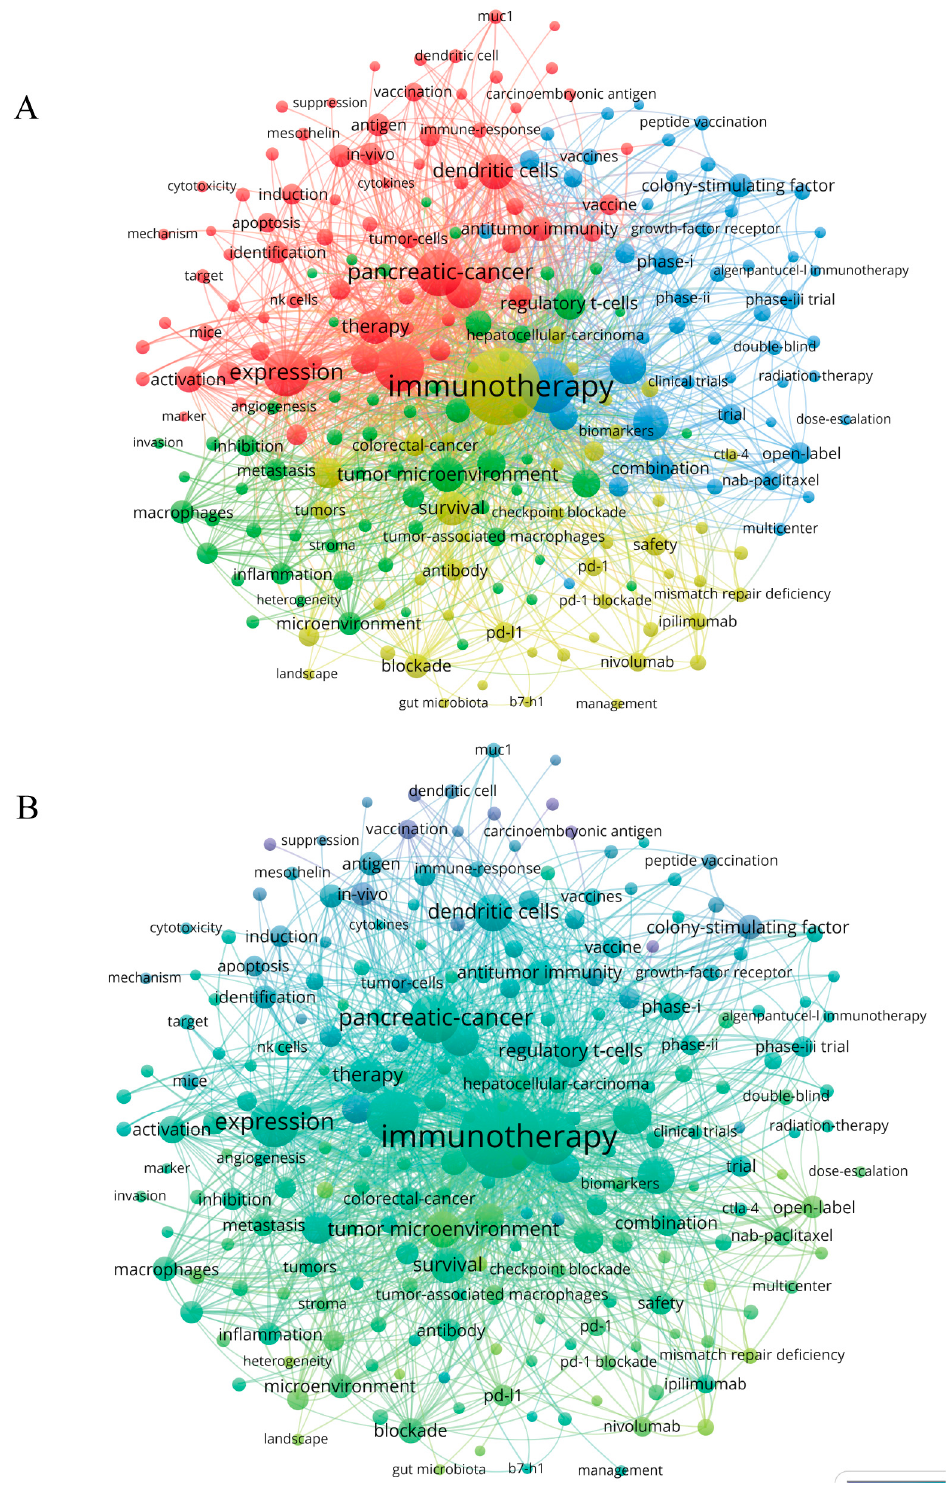
Figure 8. ( A ) The network of 223 keywords with a frequency of no fewer than 20 times. All keywords could be grouped into four clusters. ( B ) The overlay visualization map showed that keywords are colored according to their average occurrence time. Table 6. Ongoing clinical trials investigating immunotherapy in pancreatic cancer.